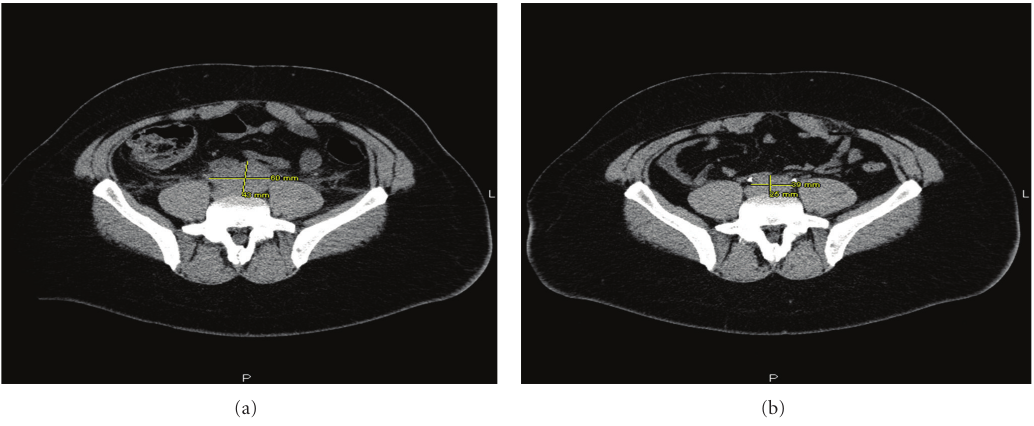
Figure 1: Abdominal CT scan showing retroperitoneal fibrosis at diagnosis and four months after operation. Table 1: Major causes of secondary retroperitoneal fibrosis Adapted from [6].